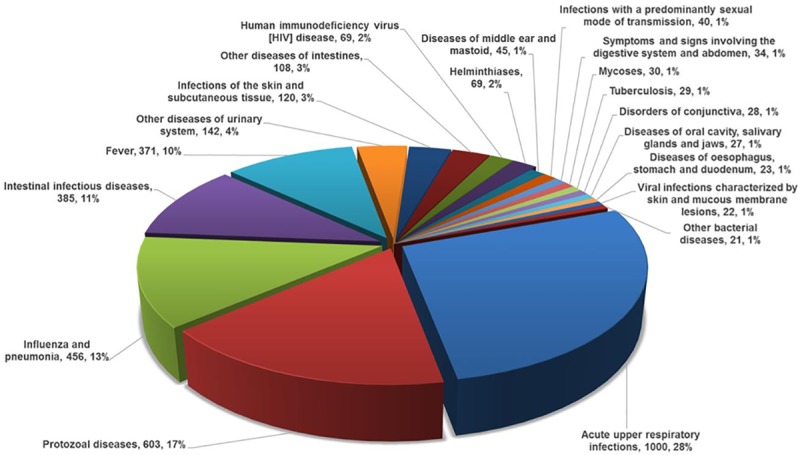
Twenty most common forms of communicable disease–ICD 10 coding (3,622 Cases).